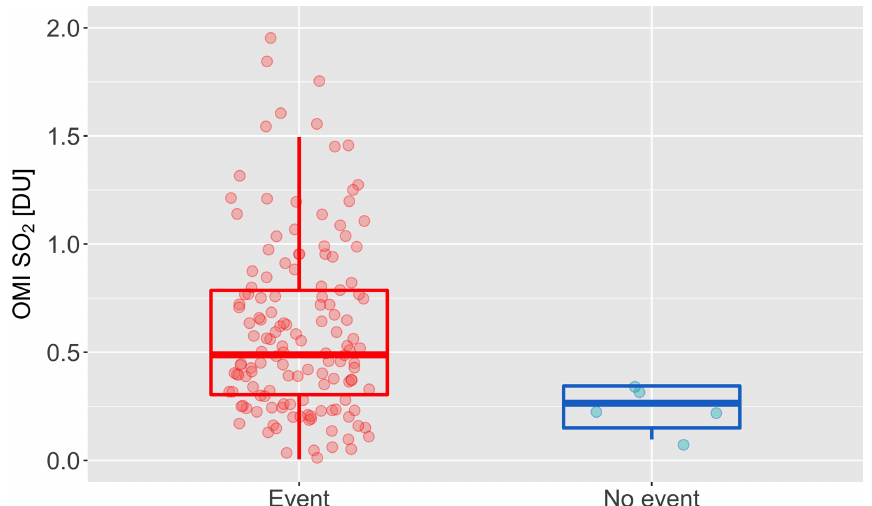
Figure A2. The average SO 2 concentration within the radius of 50km from Hada Al Sham during NPF days and nonevent days from the OMI Level 2 SO 2 planetary boundary layer product (Li et al., 2013). The concentrations are shown in Dobson units (1DU = 2 . 69 × 10 16 moleculescm − 2